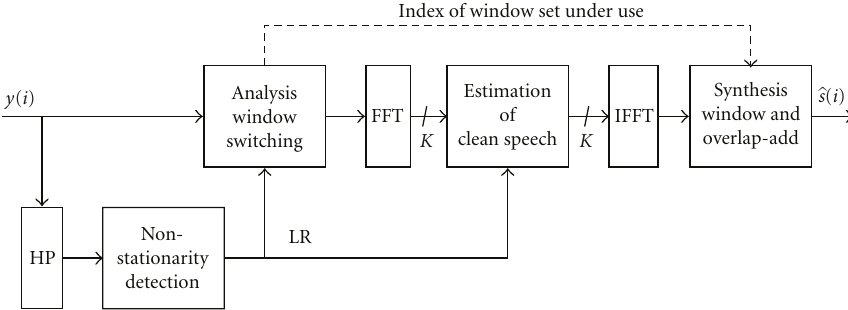
Figure 15: Overview of a noise reduction system with nonstationarity detection. The stationarity decision controls the choice of the spectral analysis-synthesis window and the estimation of the clean speech spectral coe ffi cients.